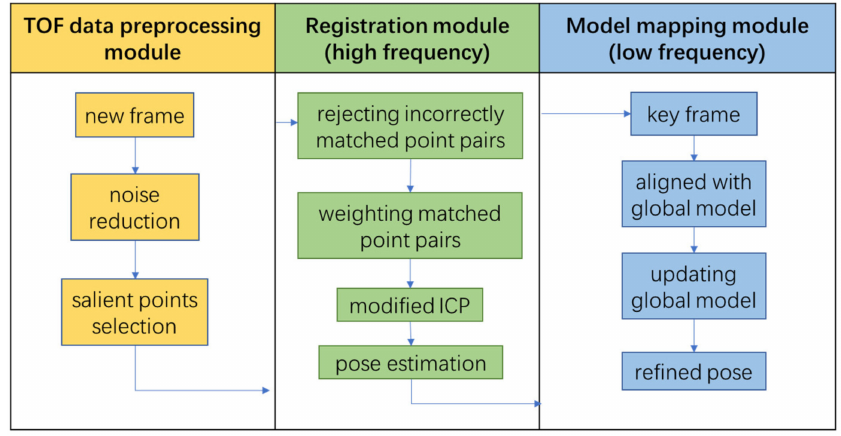
Figure 1. The pipeline of the proposed non-cooperative target pose-estimation